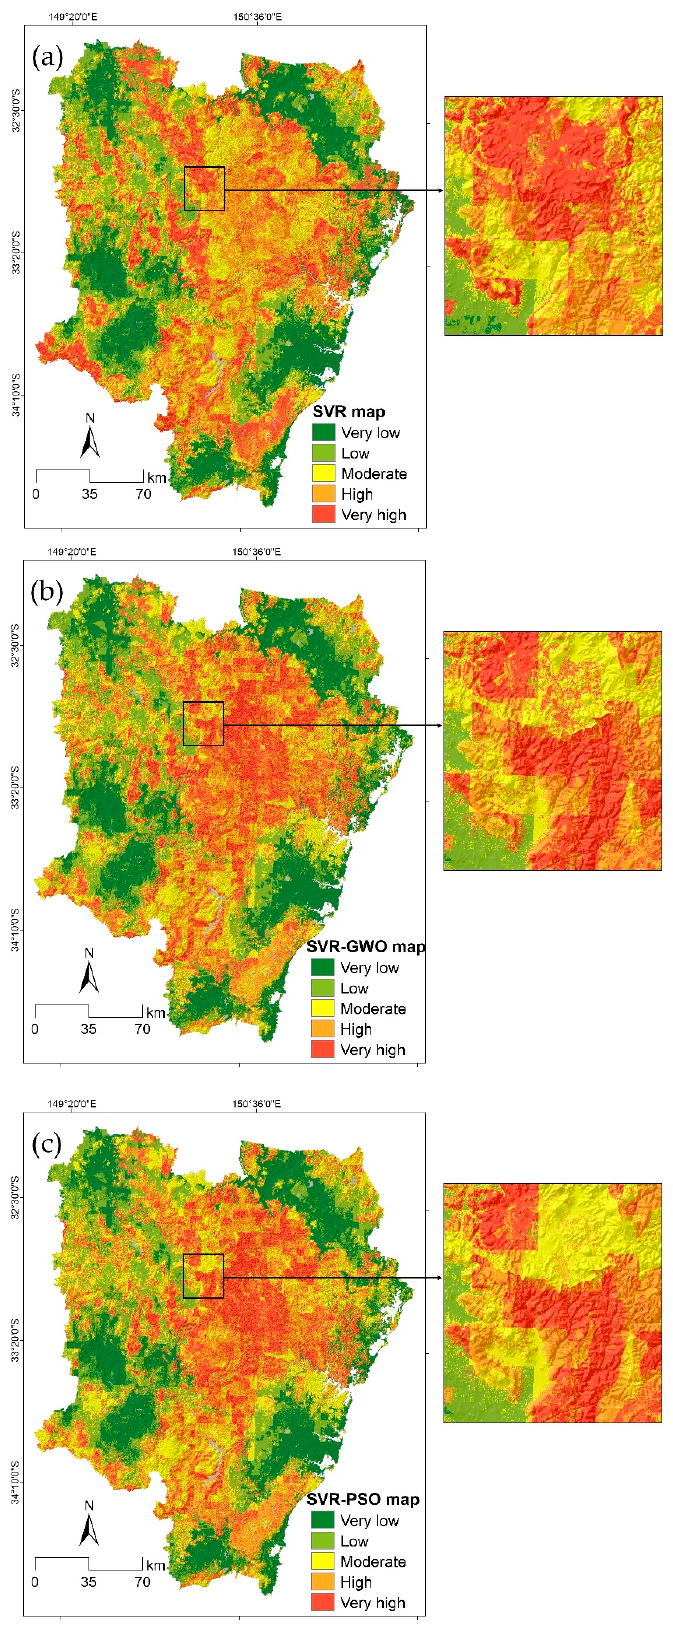
Figure 8. Wildfire susceptibility maps generated using the 2011–2018 wildfire data and ( a ) SVR, ( b ) ( b ) SVR-GWO, and ( c ) SVR-PSO SVR-GWO, and ( c ) SVR-PSO models.